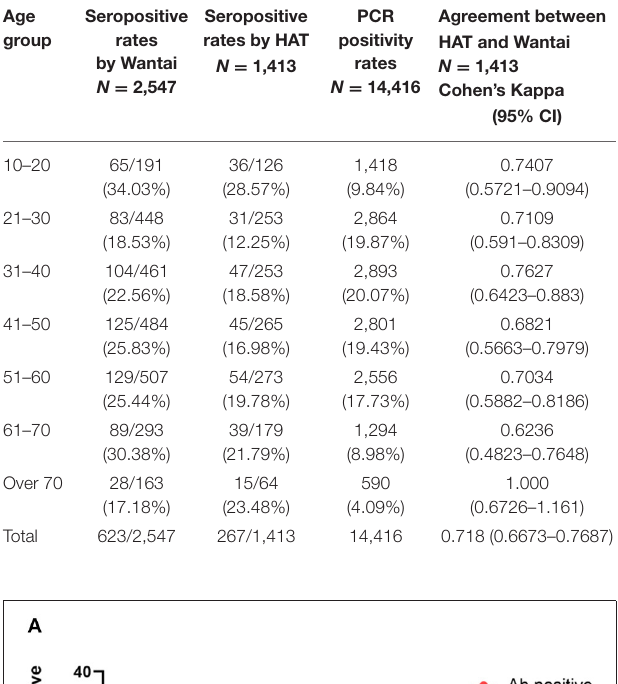
TABLE 2 | Age stratified seroprevalence rates for SARS-CoV2 in different age groups with the agreement between HAT and WANTAI. Age group